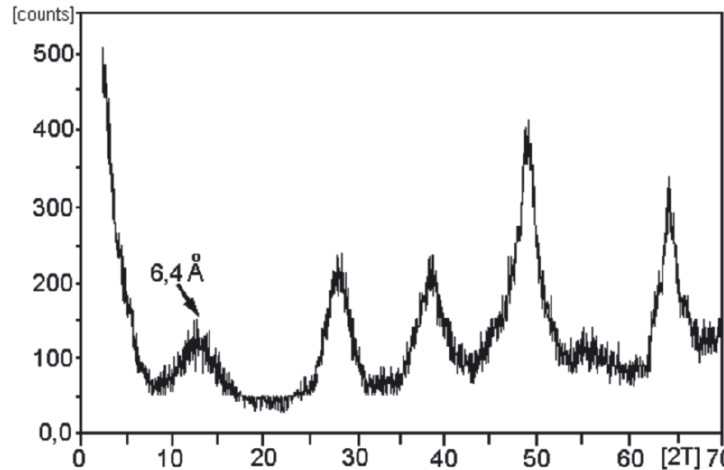
Figure 1. Five-day-old pseudoboehmite X-ray diffraction (XRD)